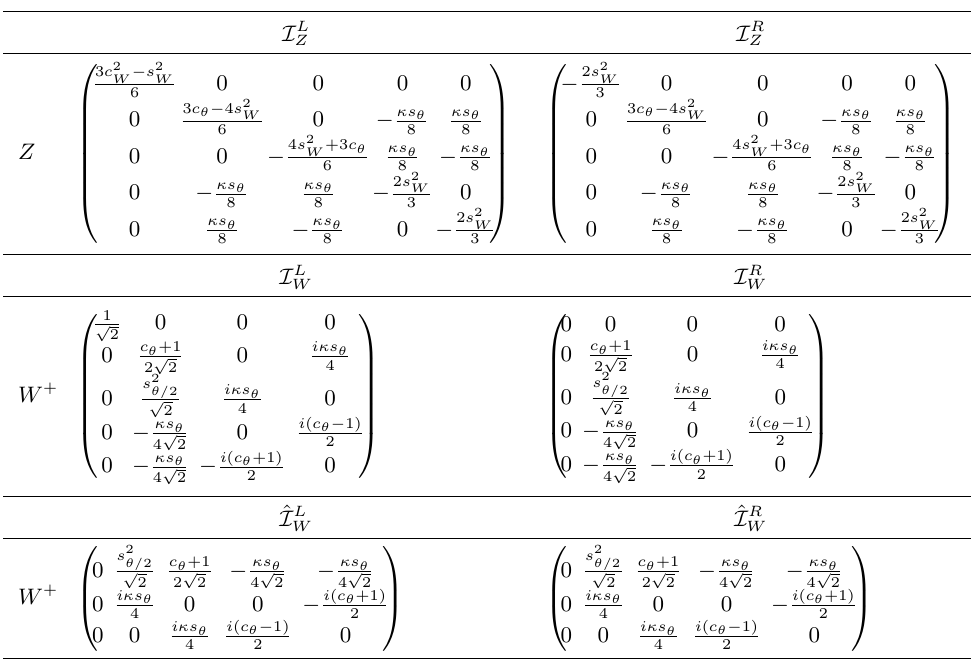
, I L,R , and ˆ I L,R . Z W W